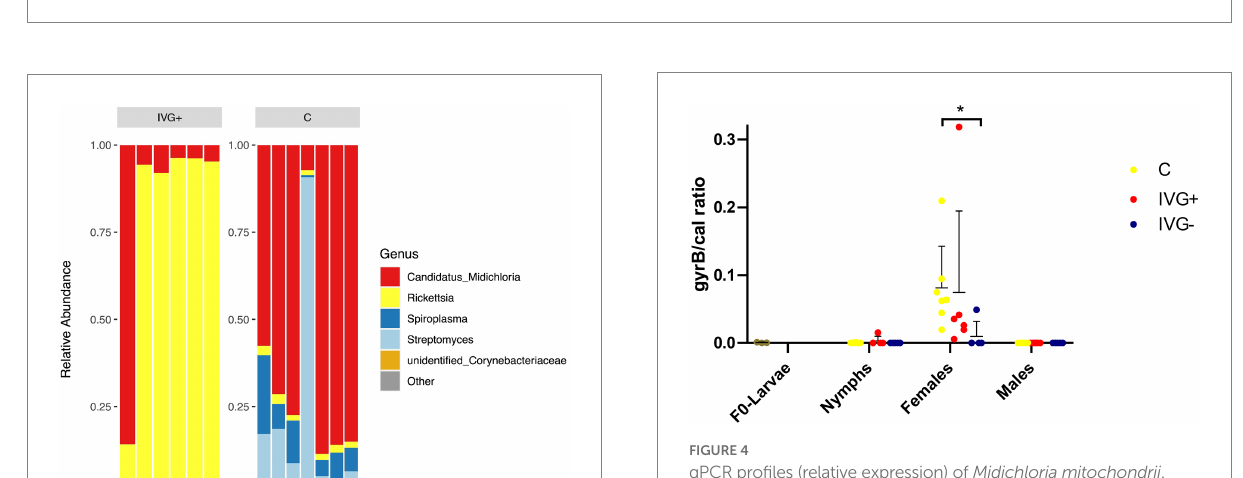
FIGURE 2 Weights (in mg) of (A) engorged Ixodes ricinus nymphs, (B) molted unfed adult I . ricinus females and males, (C) engorged and detached I . ricinus females, and (D) egg batches of I . ricinus females. Bars present means ± standard deviation. IVG + , in vitro feeding with gentamicin; IVG − ; in vitro feeding without gentamicin; C, control feeding in vivo on calves.